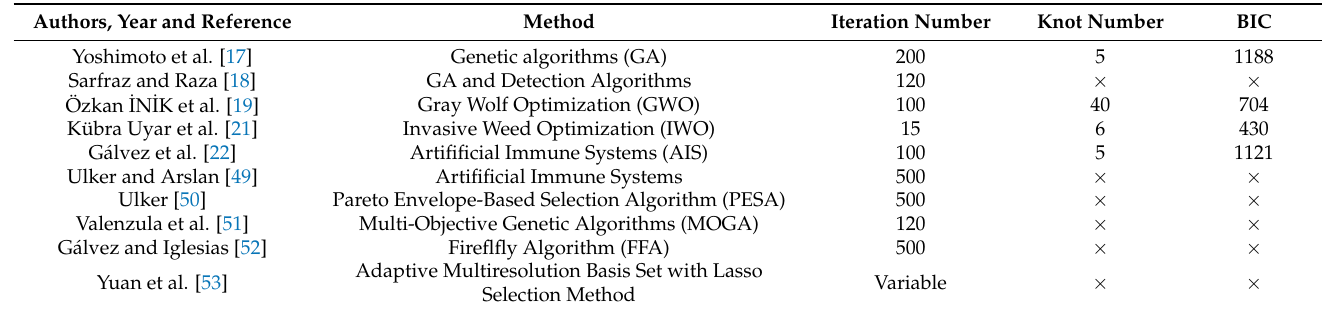
Table 4. Existing fitting methods based on optimization algorithm and their fitting results. (‘×' means that the method can not fit the function f 4 well)